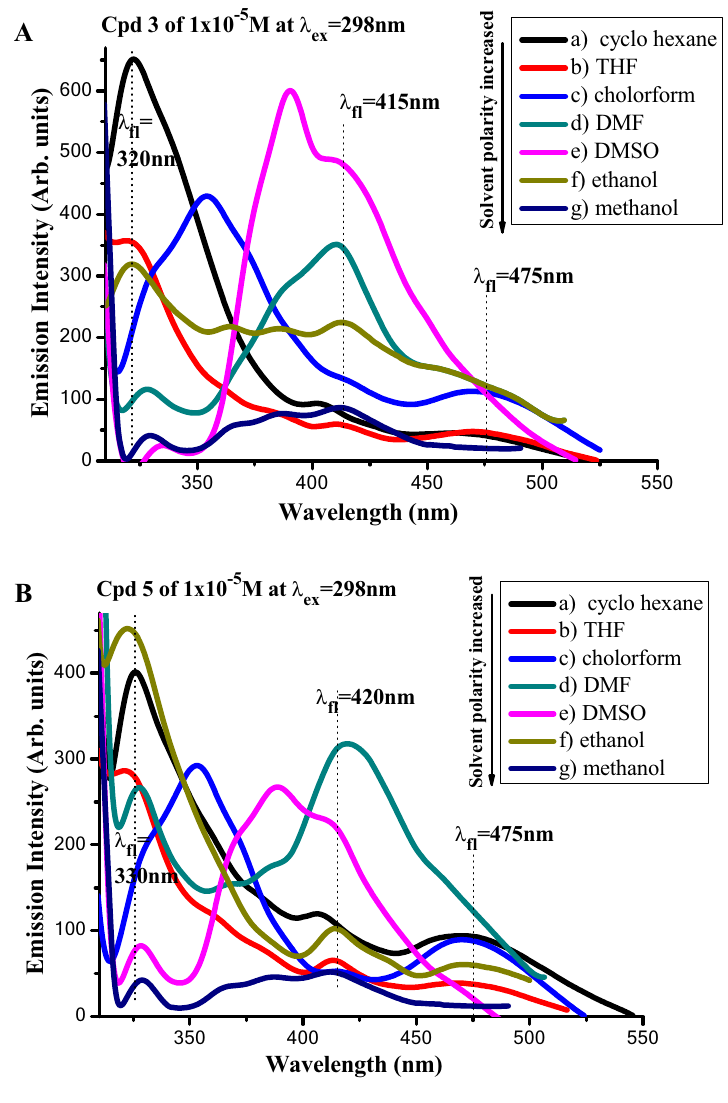
Figure 12. ( A , B ) Emission spectra of 1 × 10 −5 M of compounds (a) 3 , (b) 5 exciting wavelength (298 nm) in different